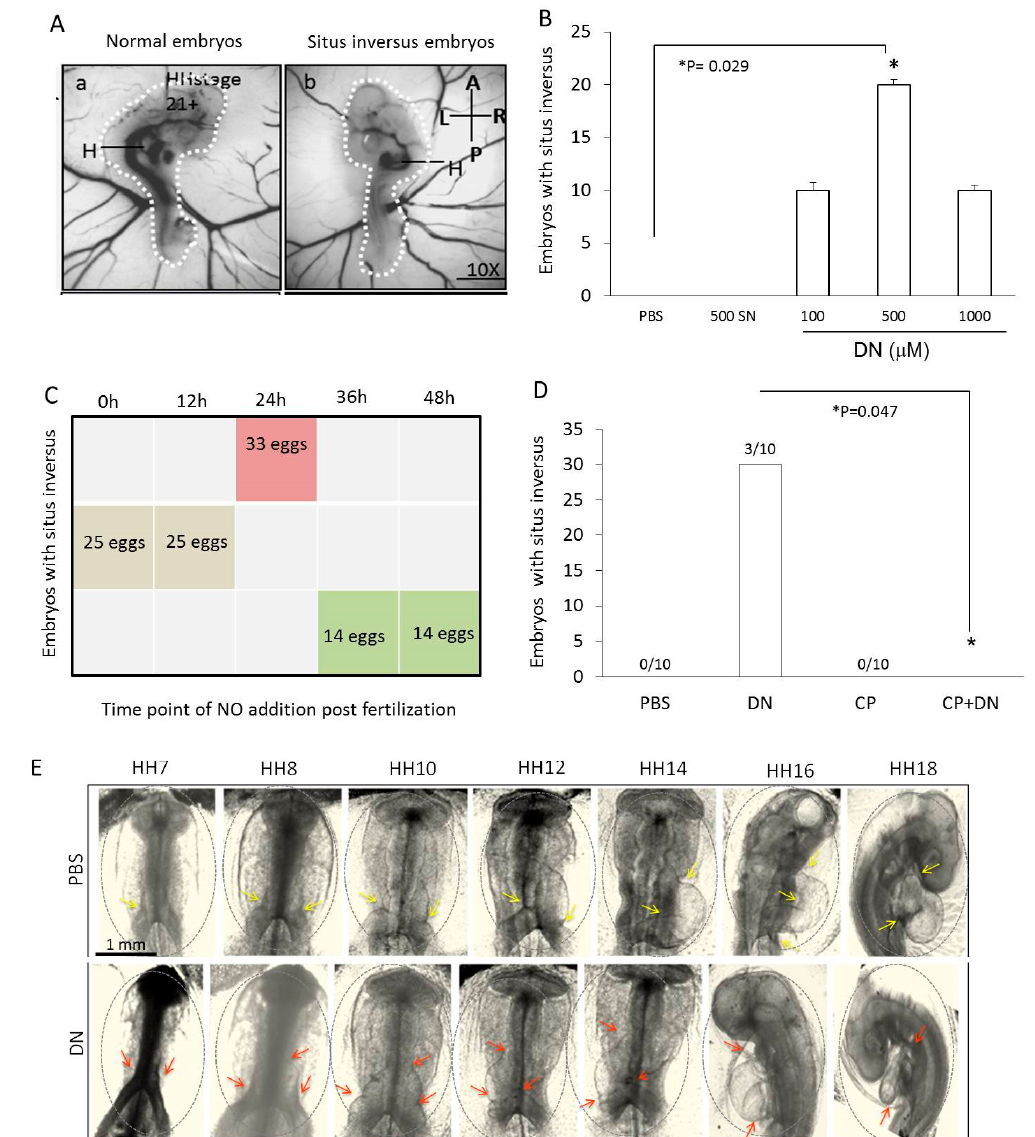
Figure 1. Dose and temporal effect of NO on heart orientation ( situs inversus ). ( A , a–b) HH stage 7–8 eggs loaded with 1X PBS shows embryo on the normal side. DEAN (DN) loaded egg shows situs inversus . Dashed lines indicate the curvature of the embryo. Arrows show the position of the heart (H) in control and DN treated embryos n = 200 embryos . ( B ) 200 white leghorn eggs were loaded with PBS or sulphoNONOate (SN) or different DEAN concentrations (100 µM, 500 µM and 1000 µM) at HH stage 7–8. The results are expressed as mean +/ − S.E. ( n = 200, * p < 0.05 vs. PBS control). ( C ) Optimization of the time point for DN treatment to identify the most effective time for DN treatment in reference to number of embryos with situs inversus . ( D ) Endogenous NO effects were tested by loading the chick eggs at 24 h with DN or cPTIO (CP) or DN + CP and the number of surviving embryos with situs inversus were scored. ( E ) PBS and DN treated eggs were opened at HH7, HH8, HH10, HH12, HH14, HH16 and HH18. Real time imaging of heart looping images were taken under inverted microscope. PBS treated eggs showing the heart development and the curvature of the body on the right side. DEAN (DN) treated eggs showing the heart development and the curvature of the body on the left side. The grey circle indicates the head to heart region of the embryo. Yellow arrows indicate the curvature during the cardiac tube looping in PBS group (normal situs). Red arrows indicate the curvature during the cardiac tube looping in DN treated group ( situs inversus ).